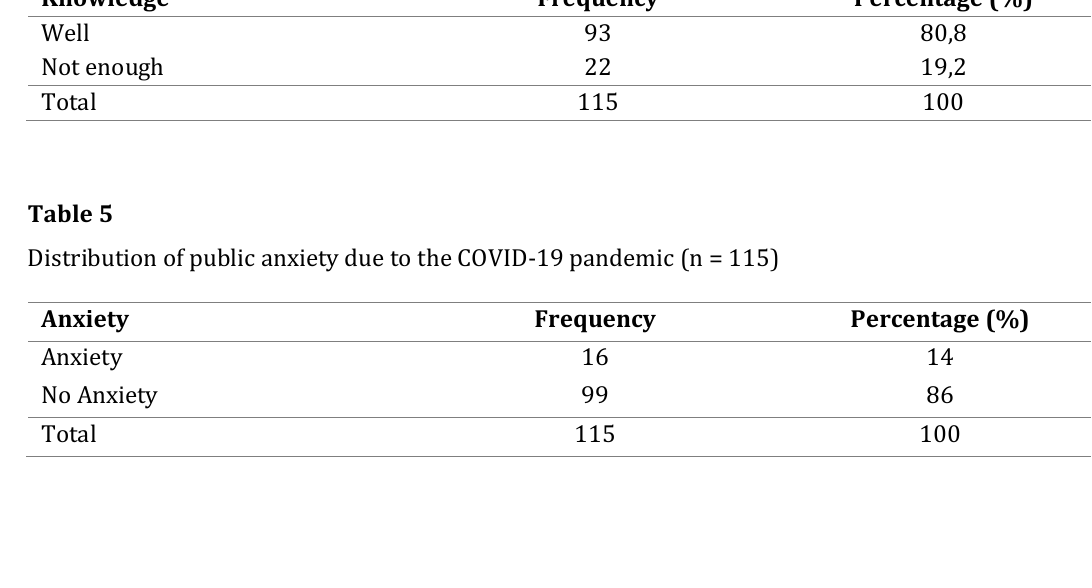
Table 4 Distribution of categories of public knowledge about the COVID-19 pandemic (n = 115) Knowledge Well Not enough